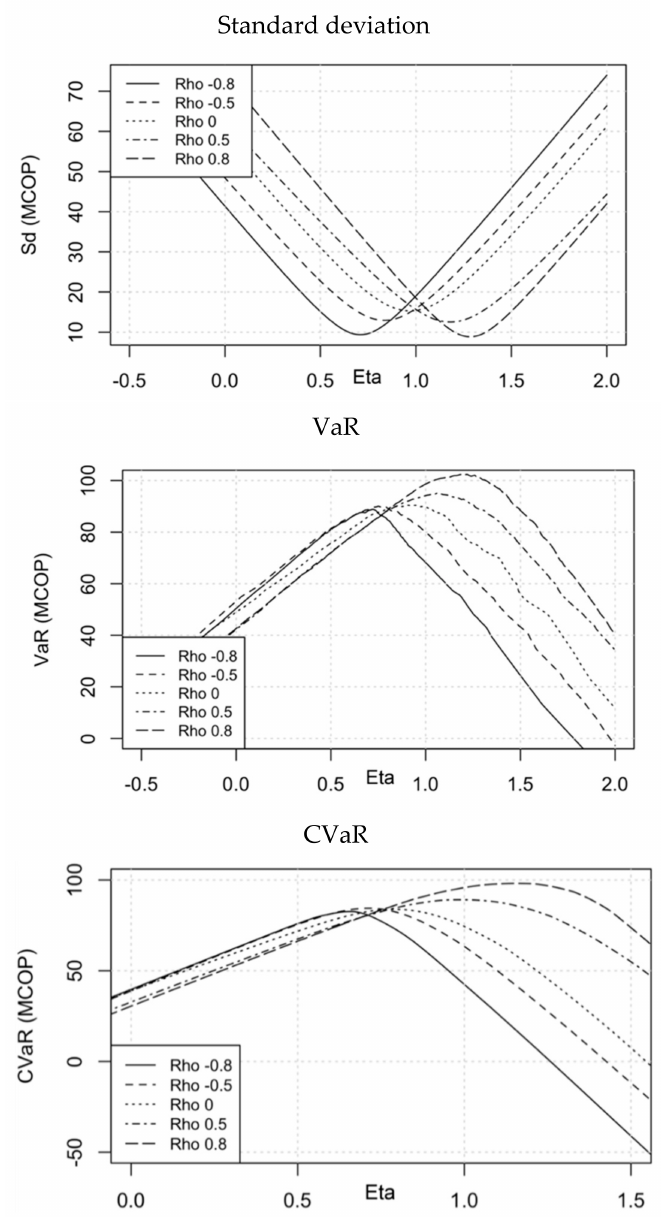
Figure 8. Sensitivity of the standard deviation, the VaR, and the CVaR to the Eta and Rho. Sensitivity of the standard deviation, the value-at-risk (VaR), and the conditional VaR (CVaR) of the net income from the sale of energy to different contracting levels (Eta) and correlation values